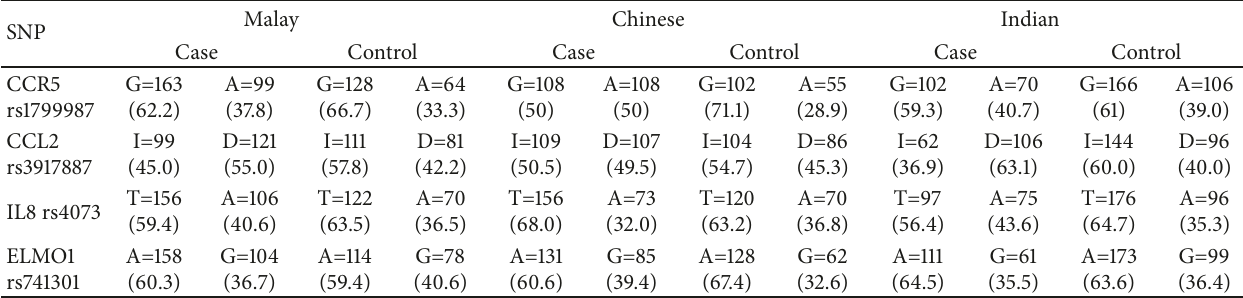
Table 4: Allele distribution and frequencies in case and control.